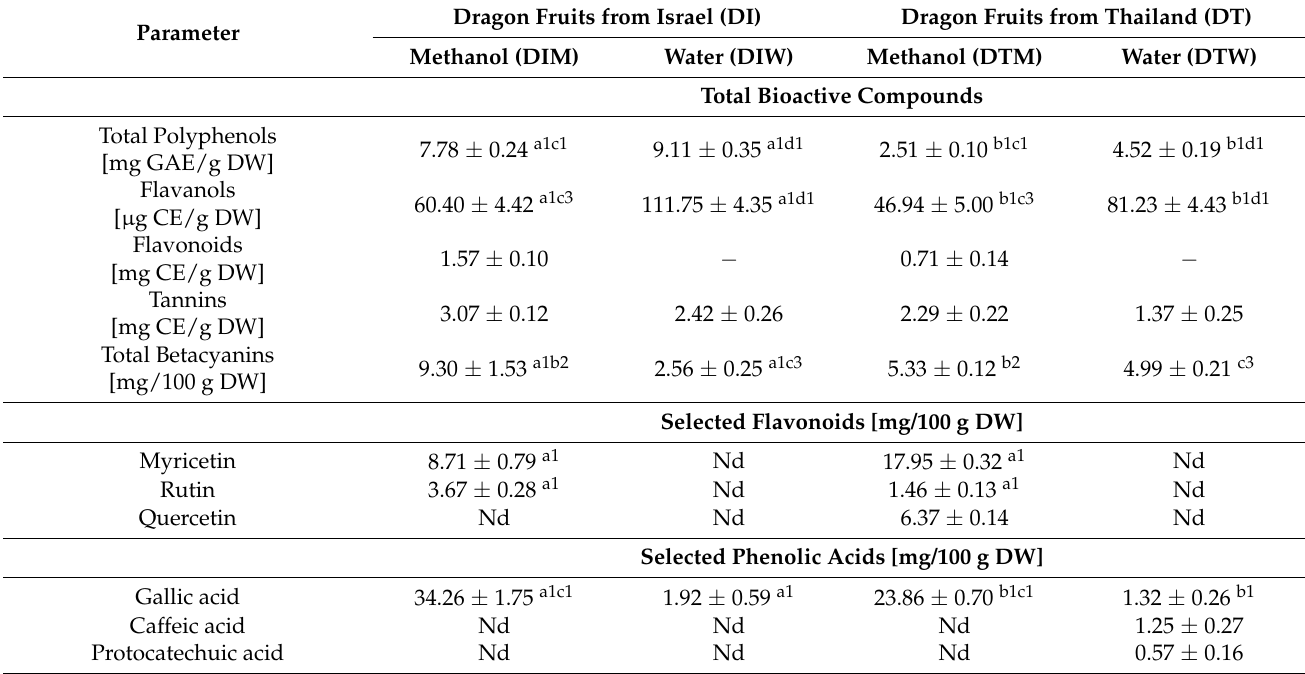
Table 1. Chemical composition of dragon fruits harvested in Israel (DI) and Thailand (DT) (mean value ± SD).